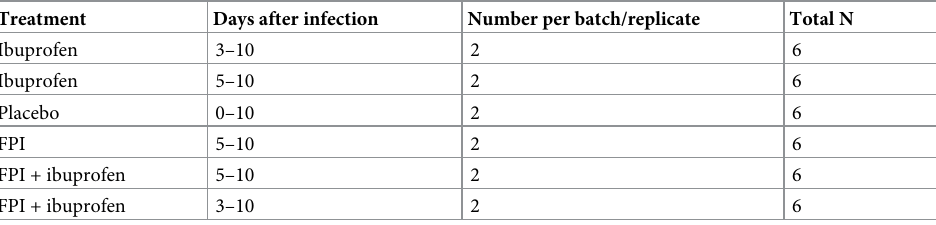
This was to blind the research team to treatment